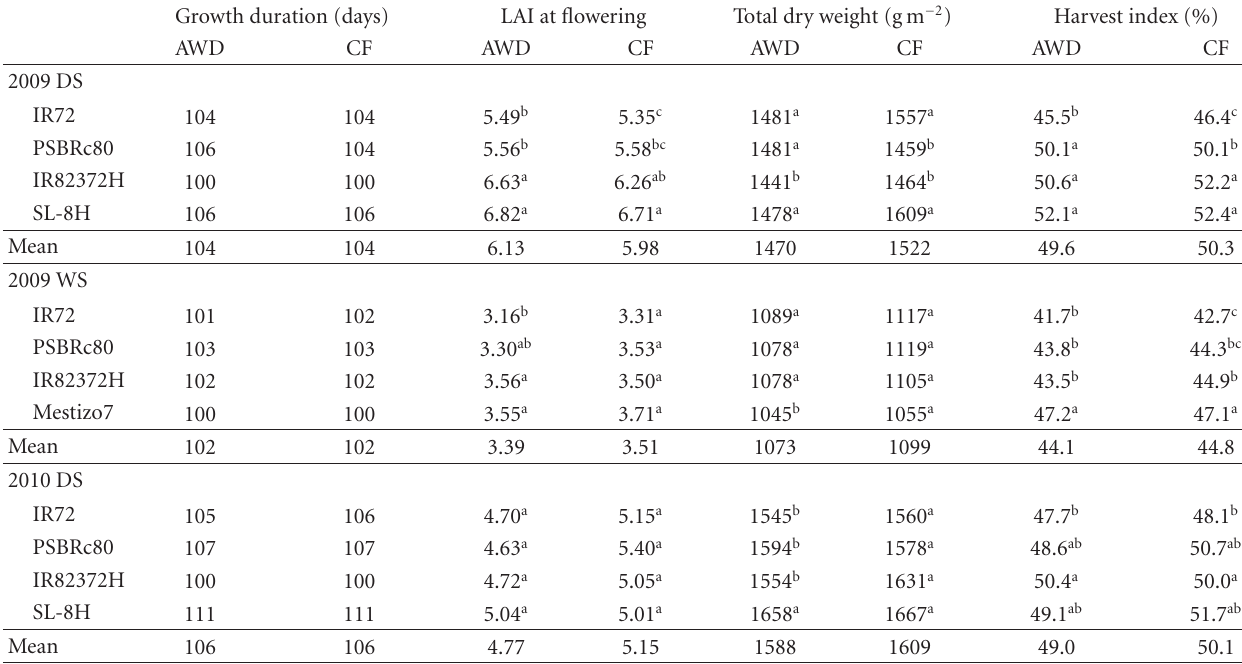
Table 5: Growth duration, leaf area index (LAI) at flowering, harvest index, and total dry weight of the four rice varieties grown under two water management treatments and two N rates at the IRRI farm for the three consecutive